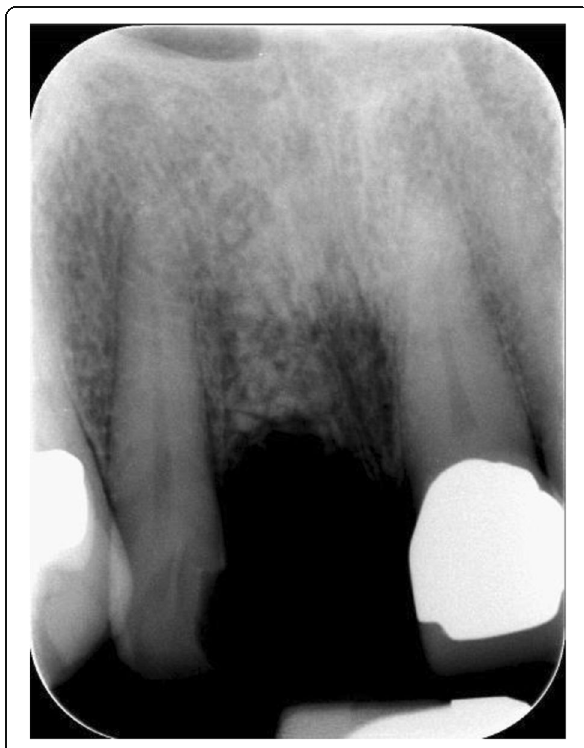
Fig. 14 Single tooth X-ray immediately after the augmentation using autogenous dentin